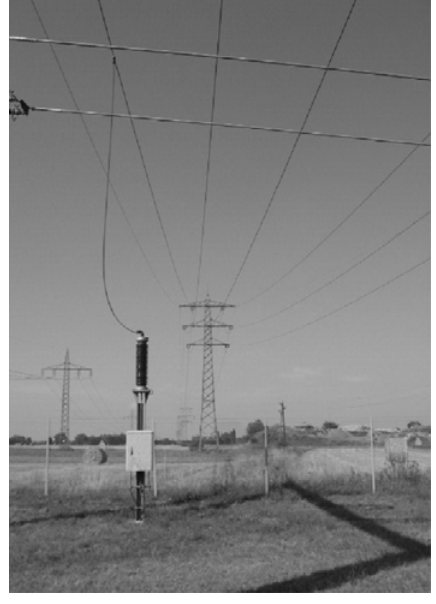
Figure 8 . Signal coupling of the low-voltage signal to the high-voltage power line using a capacity post of the TFH